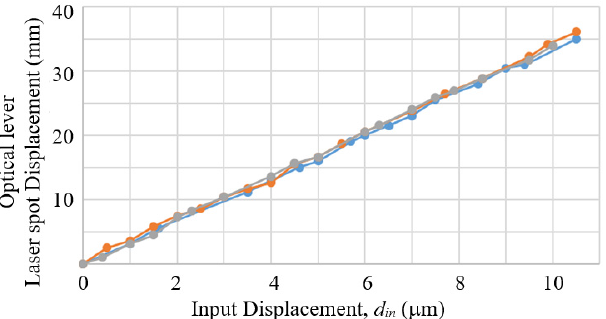
Figure 19. Results of three separate measurements of the proof-of-concept prototype by using the optical lever.